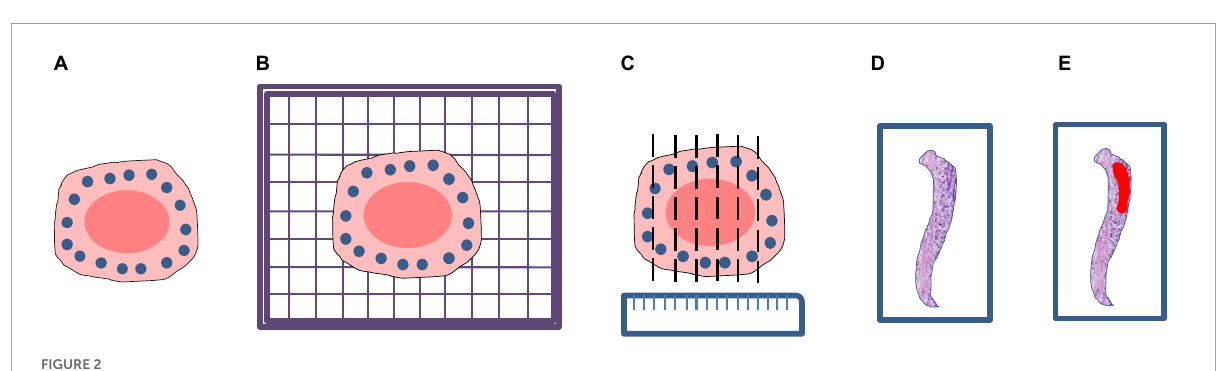
FIGURE2 Processing flow of endoscopic submucosal dissection specimen: (A) Stretching and fixation; (B) macroscopic photography on a cork plate; (C) sectioning of the fixed specimen; (D) scanning; (E) annotation.